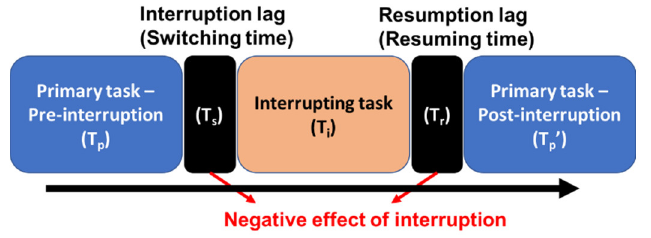
Figure 1. Time course of interruption.